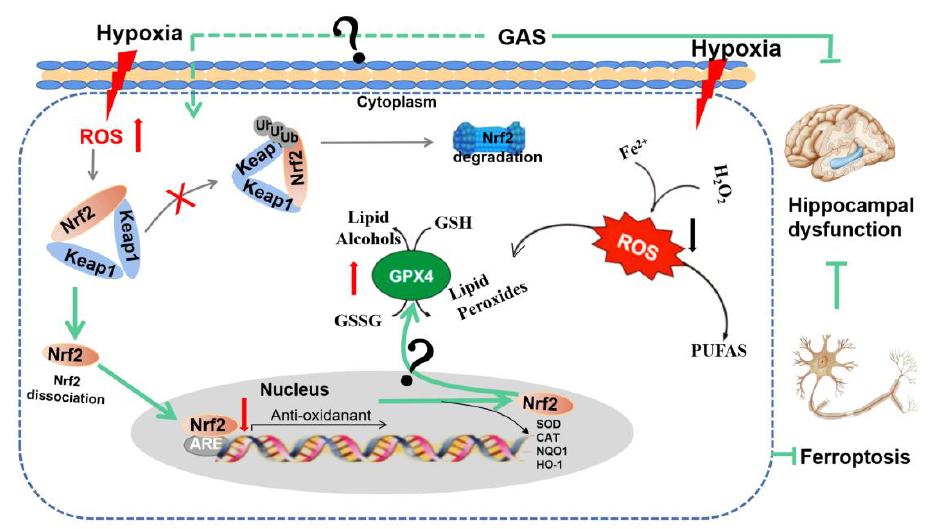
Figure 7. GAS ameliorates cognitive dysfunction in VaD rats by suppressing ferroptosis via the regulation of the Nrf2/Keap1-GPx4 signaling pathway. The illustration represents how the GAS up-regulates the Nrf2 gene, promotes Nrf2 release from the complex of Keap1 and Nrf2. Then, Nrf2 enters the nucleus and binds with antioxidant response elements (ARE), thereby. increasing the expression of GPx4 to decrease iron deposition, strengthen antioxidant capacity and decrease lipid